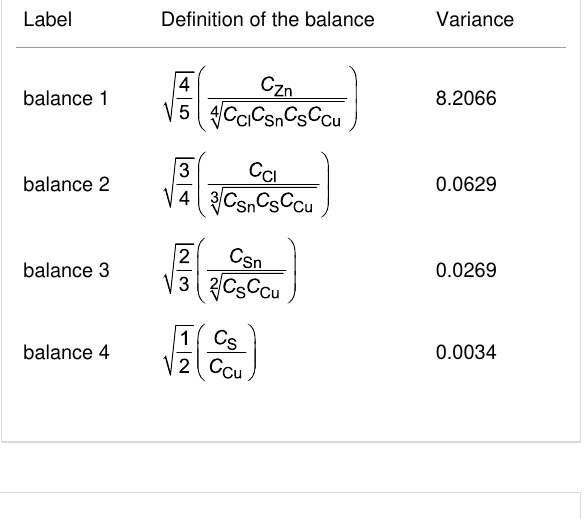
Table 2: Result of the isometric log-ratio analysis on the basis of the decreasing of the variance criteria. When the denominator is charac- terized by more than one variable, it is represented by the geometric mean of the involved